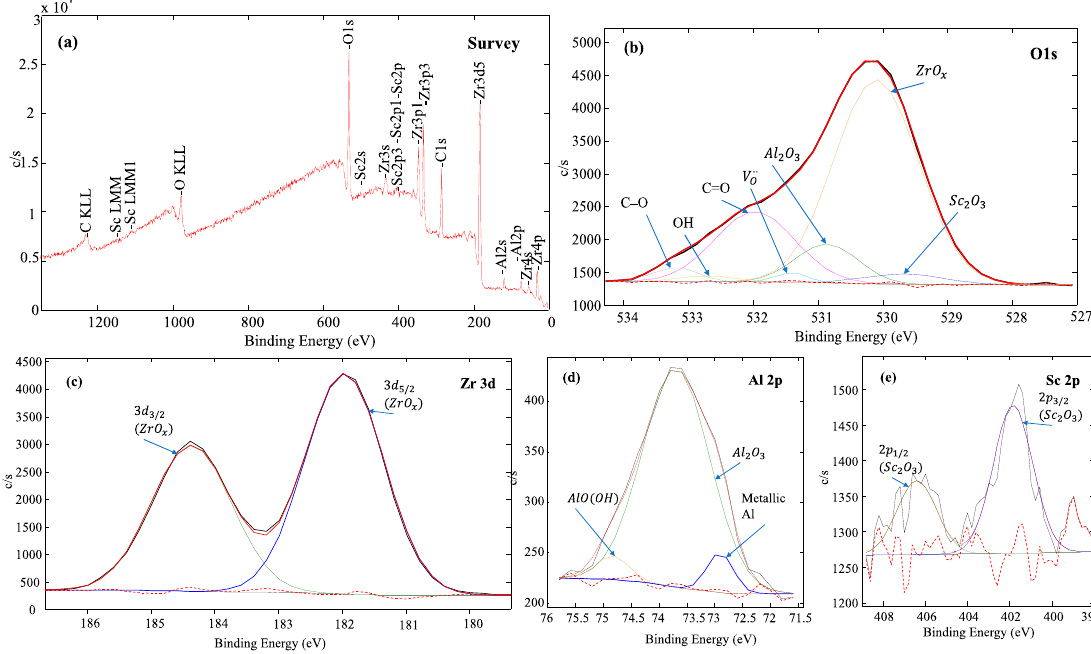
Figure 3. XPS spectra of 6ScAlSZ thin films ( v d = 0.2 nm/s, T d = 300°C): ( a ) survey, ( b ) Zr O 1 s , ( c )